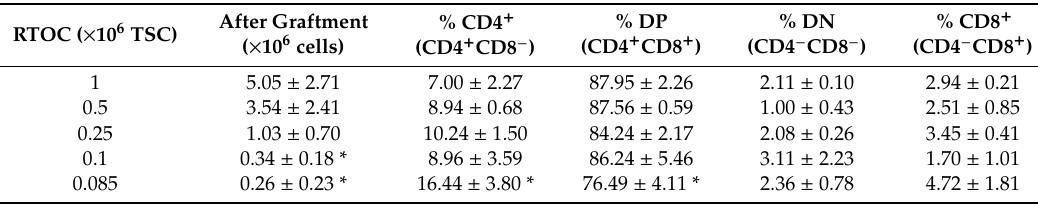
Table 1. Cellularity and proportions of thymocyte subsets.